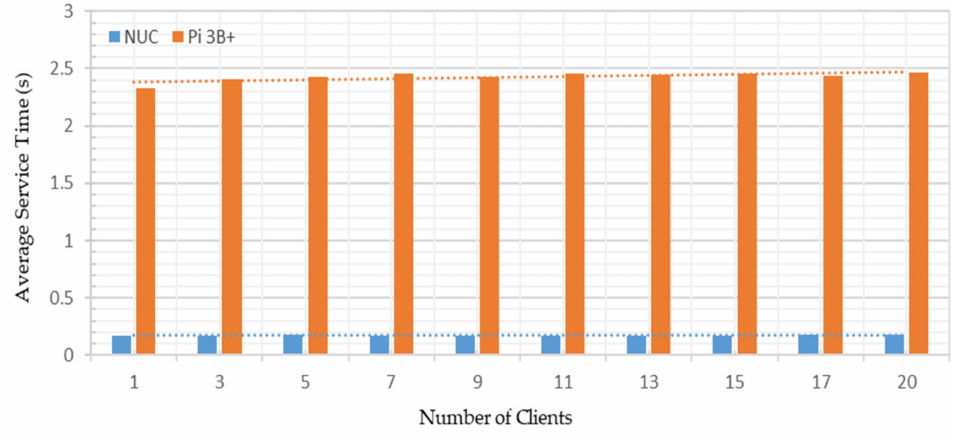
Figure 24. Average service time requirement with varying the number of web service